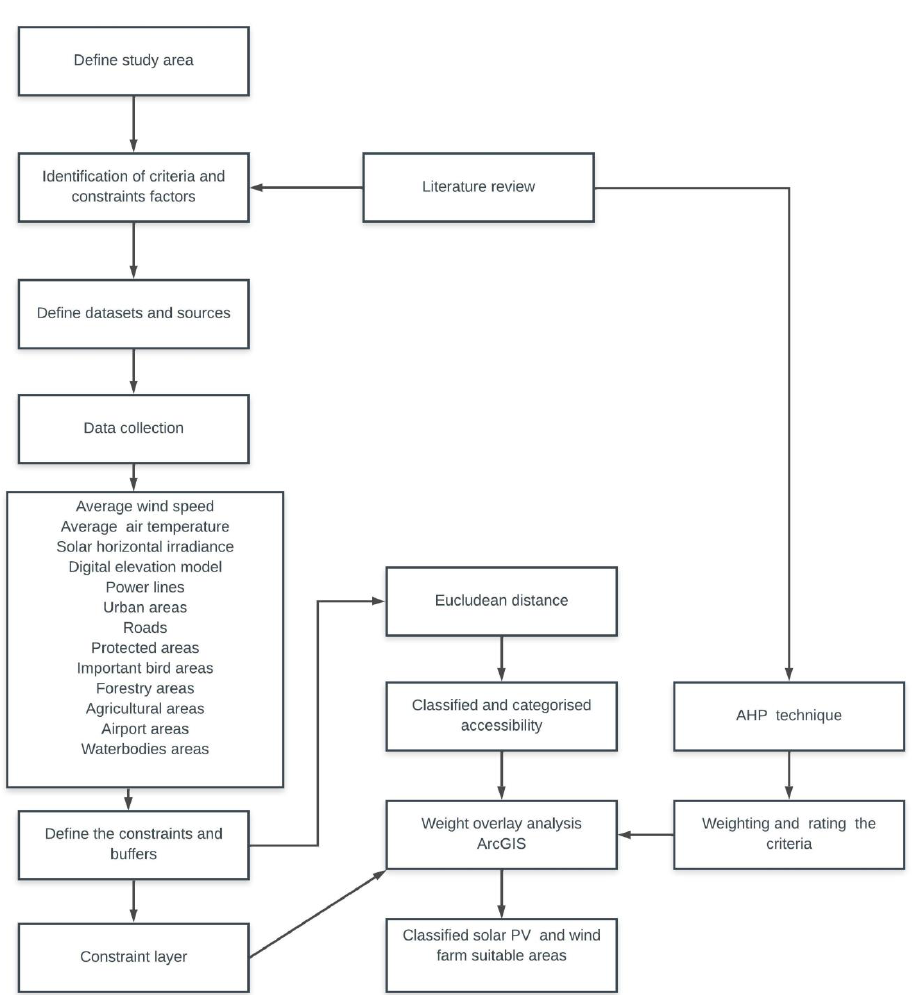
Figure 1. The methodological framework of the solar PV and wind turbine site selection.